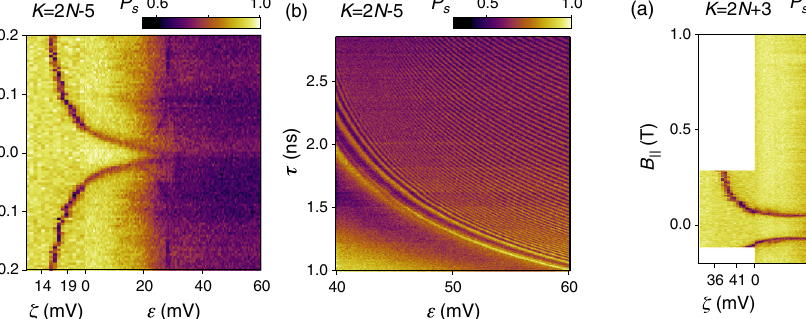
FIG. 11. Leakage spectroscopy (a) and time-resolved measure- ment of exchange oscillations (b) for the multielectron dot occupied by 2 N þ 3